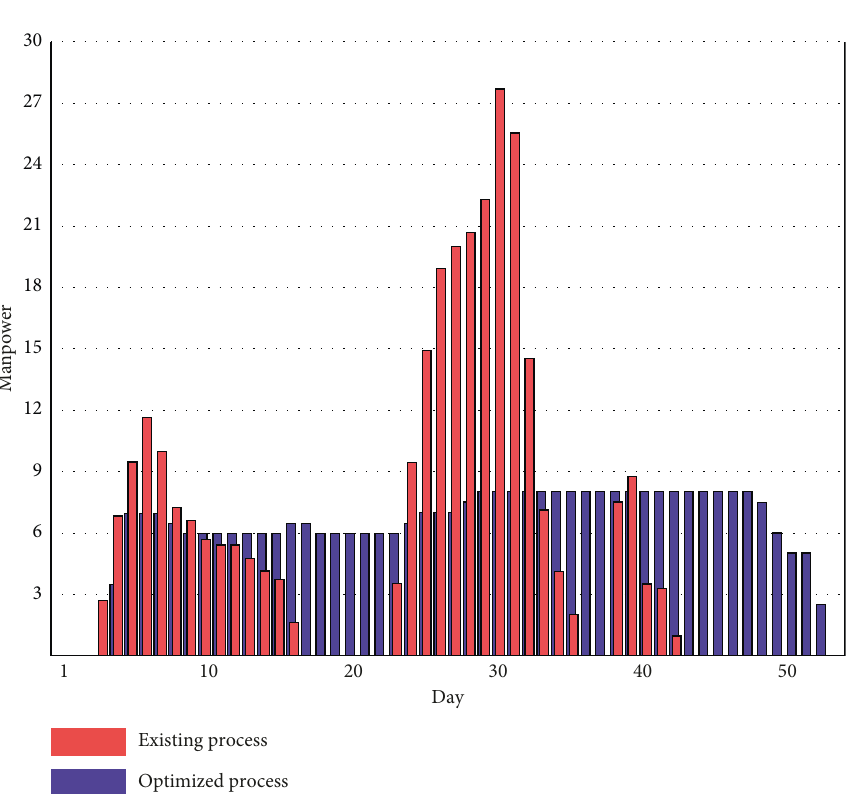
Figure 10: Manpower comparison between existing and optimized